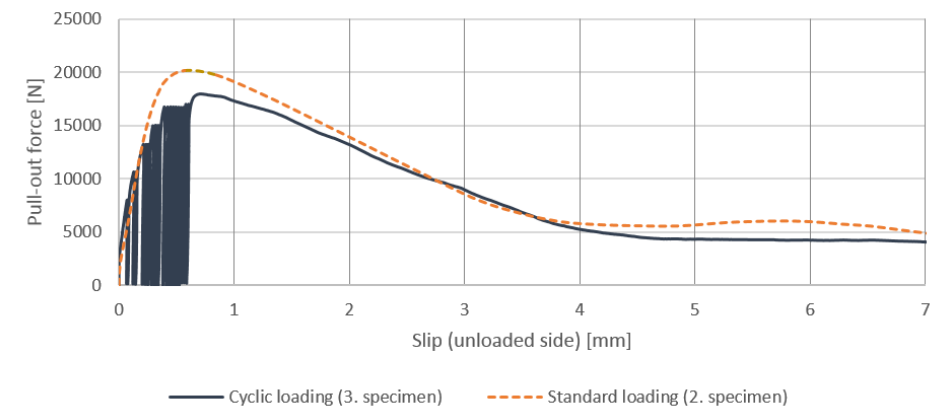
Figure 2. Comparison of standard and cyclic loading force for lightweight